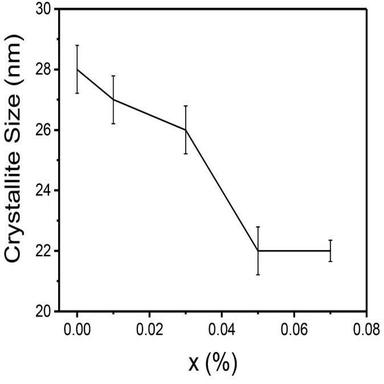
Variation of crystallite size with x concentration for ZnFe(2-x)LuxO4 nanoparticles.